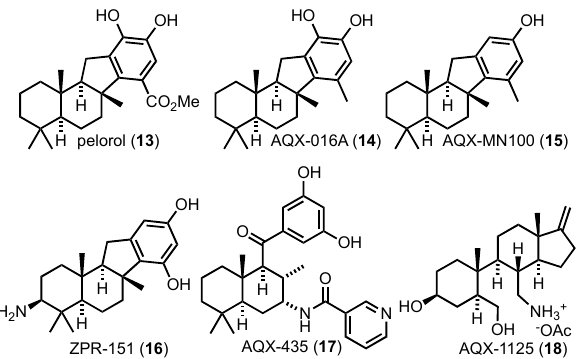
Figure 8. SHIP1 Agonists.